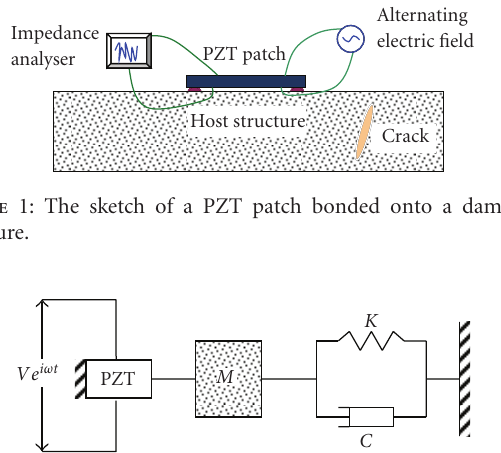
Figure 2: 1D model used to represent a PZT-driven dynamic structural